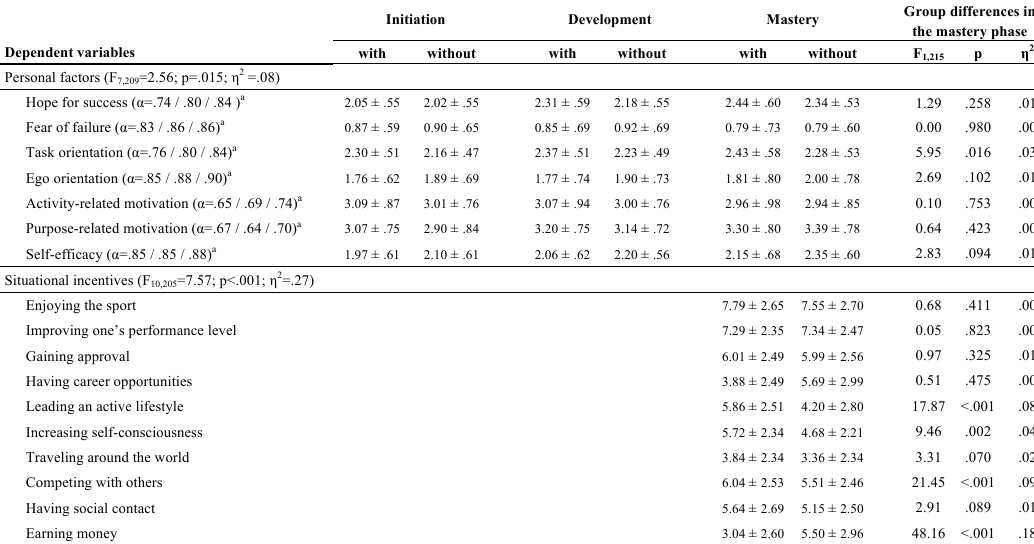
Table 3. Personal factors and situational incentives in the course of a career (M ± S) and multi- and univariate results of group differences between athletes with and without a disability in the mastery phase (controlled for gender and